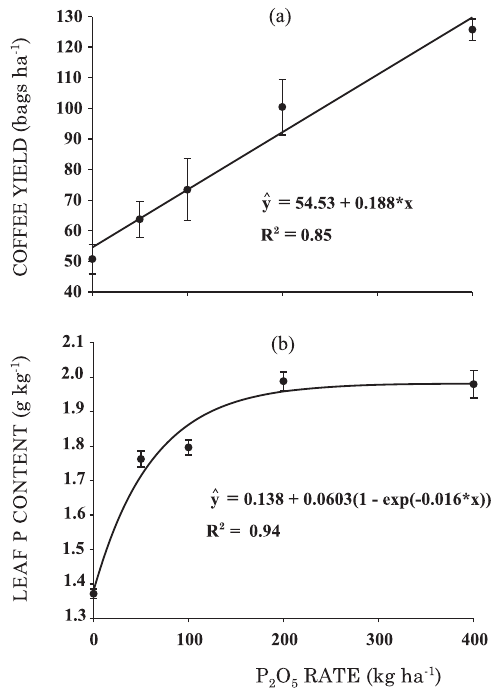
Figure 1. Coffee yield (a) and leaf phosphorus contents (b) of irrigated coffee fertilized with different annual phosphorus rates in a Red Latosol (Oxisol) (harvest 2008). * Significant by t test at 5 %.